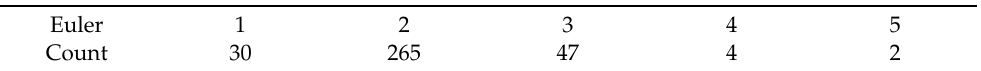
Table 11. Second decomposition type—distribution of combinatorial Euler characteristics of Seg- ment3DNet objects from border interior overlay.